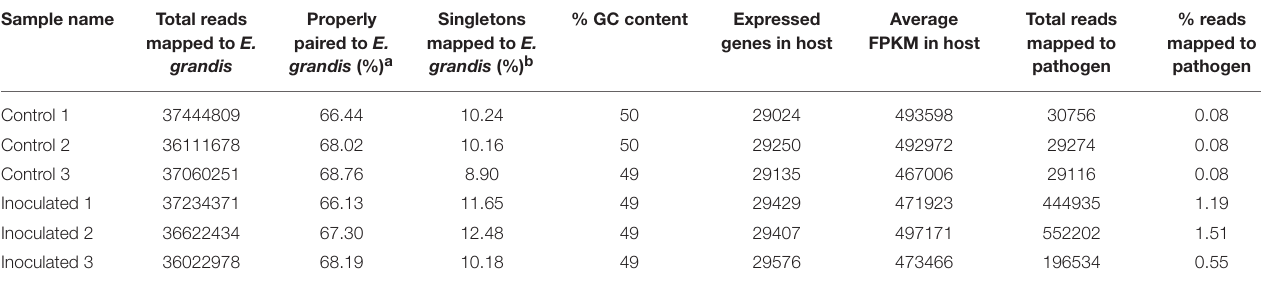
TABLE 2 | Flagstat and FastQC RNA-seq mapping statistics of Eucalyptus nitens reads to the v1.1 Eucalyptus grandis and Phytophthora cinnamomi var cinnamomi genomes. Sample